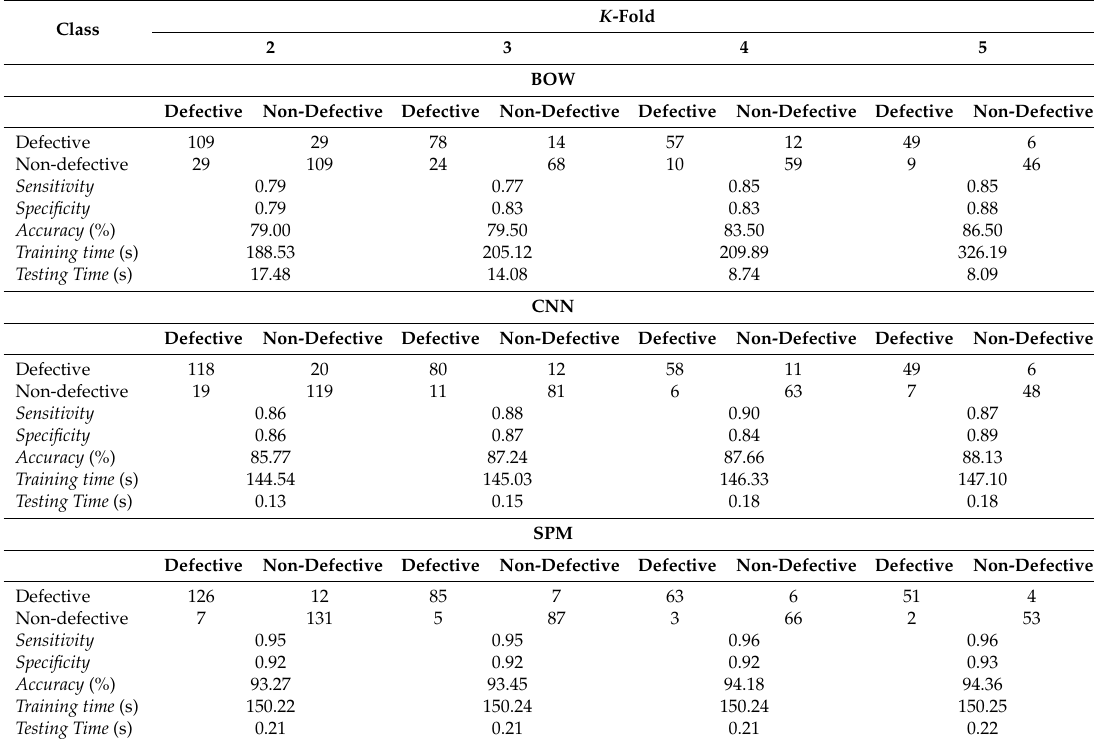
Table 2. Confusion matrix of K -fold cross-validation for each method with SVM